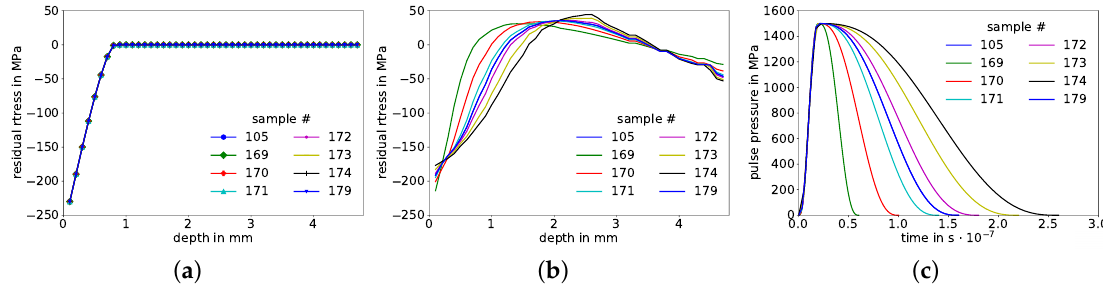
Figure 8. ( a ) Super-imposed but indistinguishable residual stress distributions over depth predicted by the semi-analytical model for different pressure pulses, i.e., identical inputs for the corrective ANN-model. ( b ) Corresponding output targets: Eight unique residual stress distributions over depth predicted by the FE model and ( c ) corresponding distinctive pressure pulses over time that were used as input for both models, exhibiting different pulse durations but identical maximum pressures and times of respective maximum